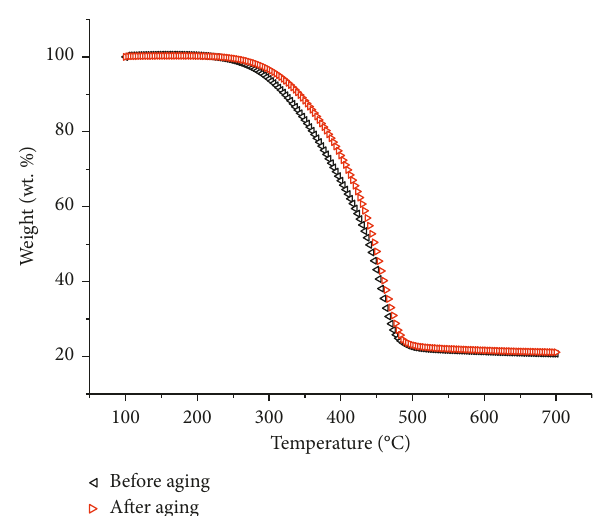
Figure 7: TG curves of WPP/OREC-1.5-modified asphalt before and after aging.